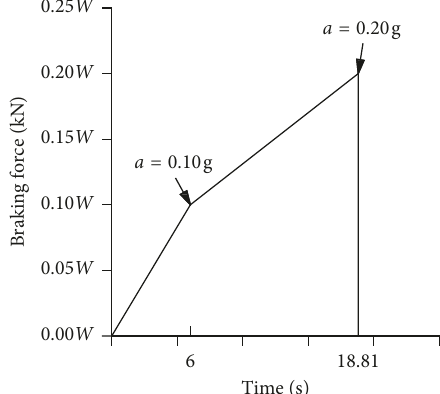
Figure 16: Braking force-loading time-history curve.